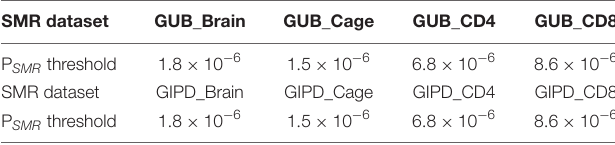
TABLE 2 | P SMR threshold for these eight SMR datasets.